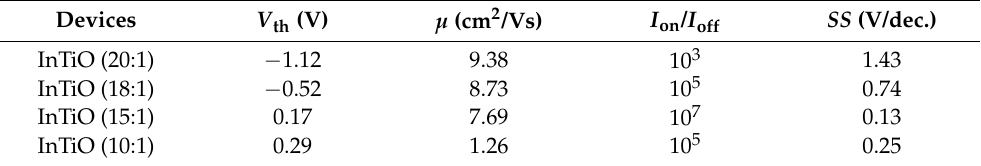
Table 1. Electrical parameters of InTiO TFTs with different Ti 4+ doping ratios.